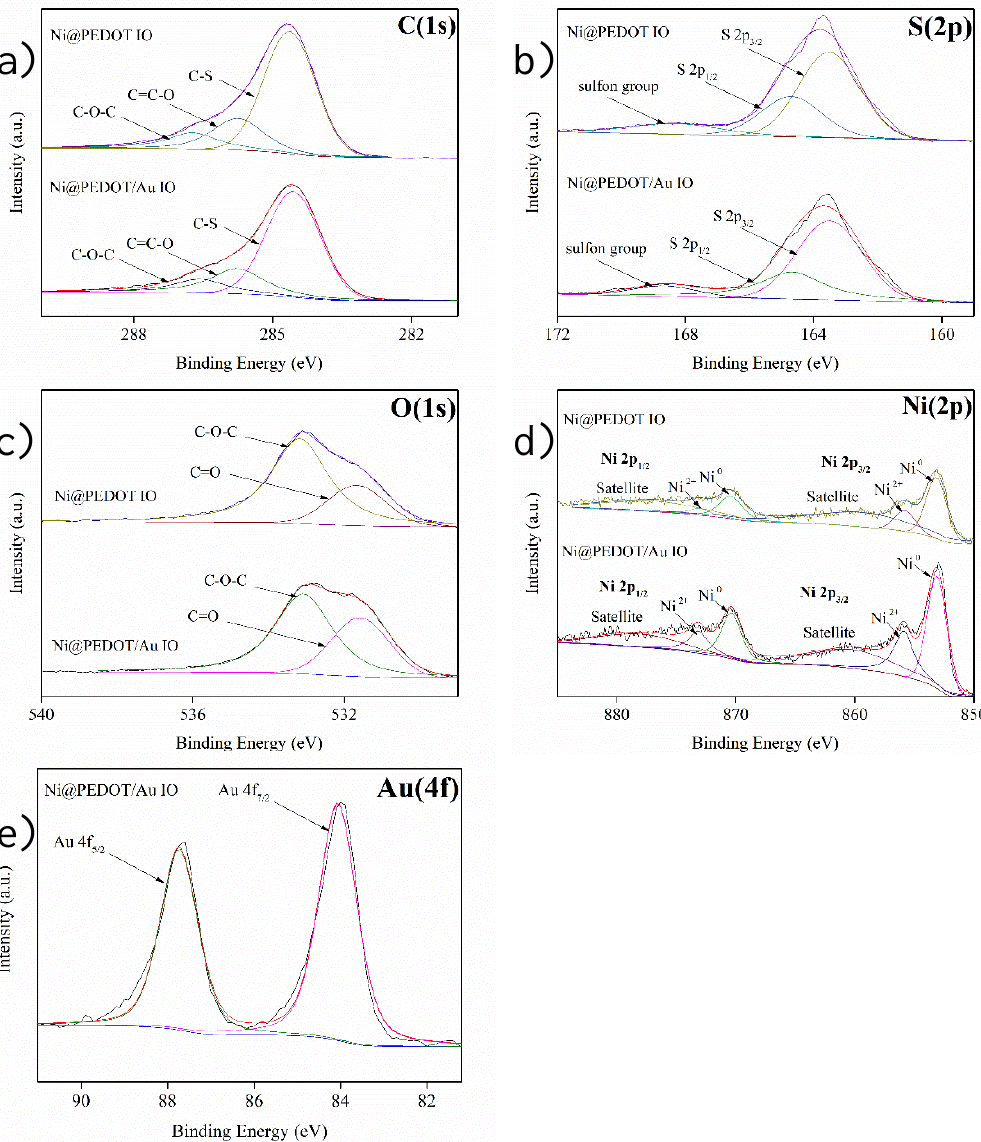
Figure 6. The XPS spectra of ( a ) C(1s), ( b ) O(1s), ( c ) S(2p), ( d ) Ni(2p), and ( e ) Au(4f) for Ni@PEDOT and Ni@PEDOT/Au inverse opals, respectively.